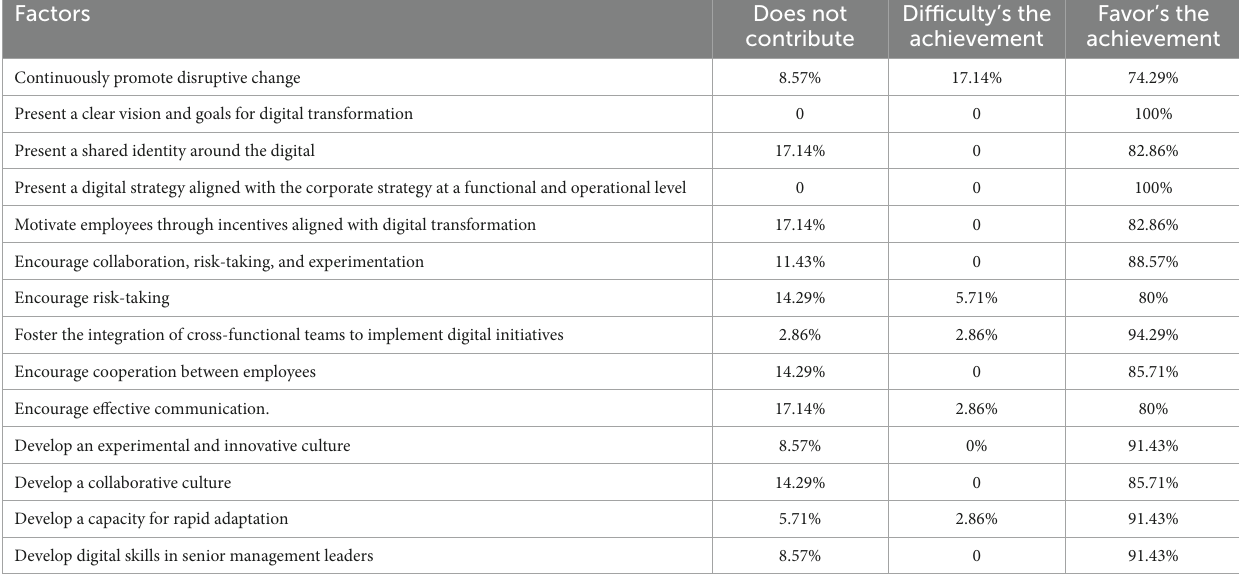
TABLE 2 Results from the first